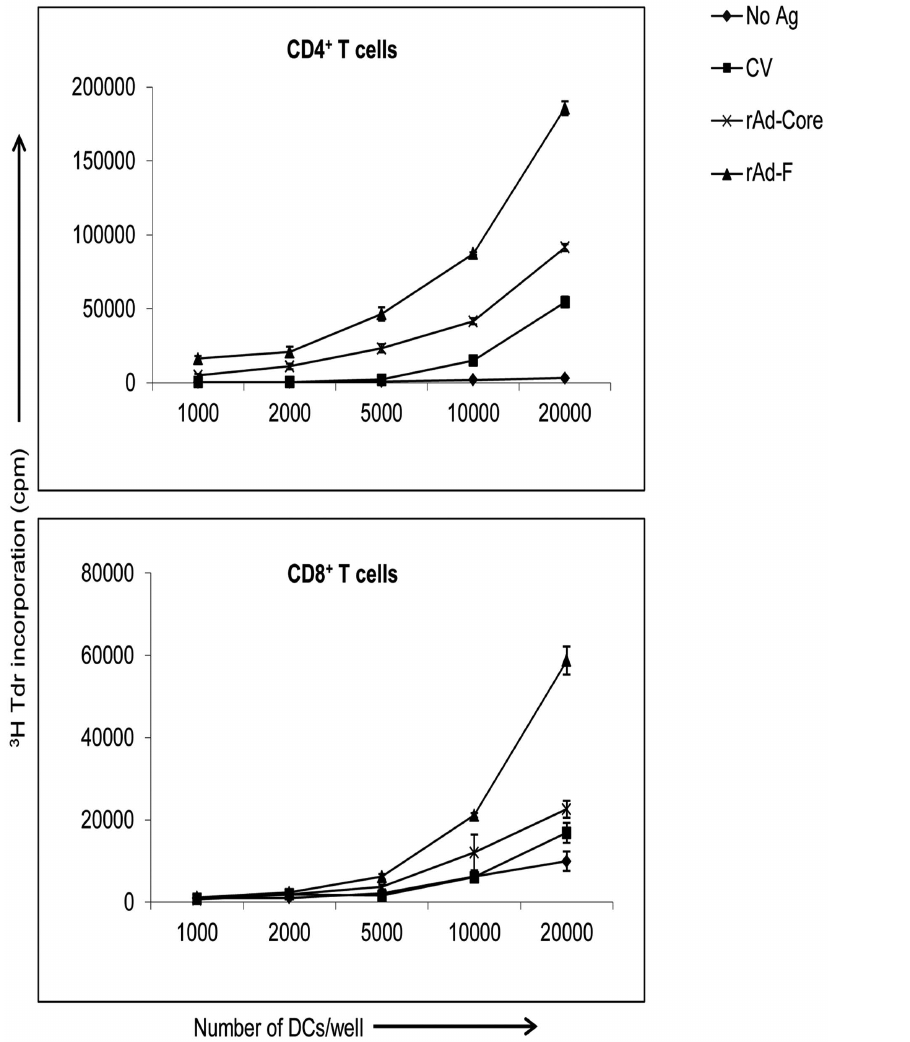
Figure 7. Primary proliferative response of naive autologous CD4 + and CD8 + T cells upon stimulation by DCs expressing HCV F and core antigens. Purified CD4 + and CD8 + T cells were stimulated using DCs expressing HCV antigens at various DC:T cell ratios. The proliferation of T cells was determined by a 3 H-thymidine incorporation assay. The lines on the graphs represent DCs with no antigens, DCs expressing control vector, core protein, and F protein according to the figure legends. Mean and standard deviations of triplicate wells are shown. The data are representative of 5 repeated experiments with 5 different donors.